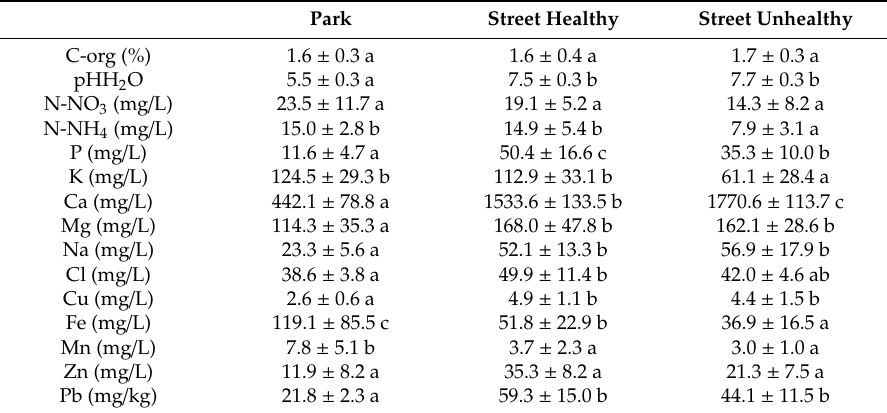
Table 3. Mean values of selected physical and chemical properties of soils.